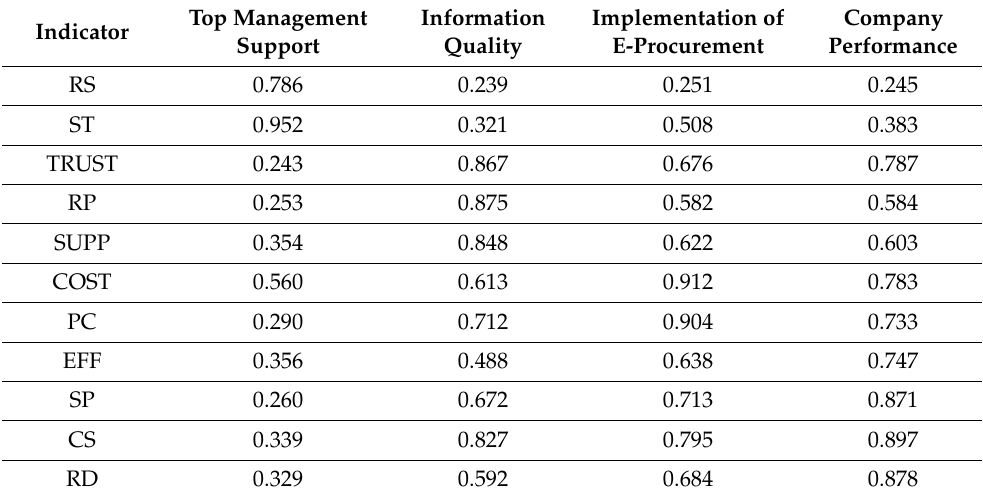
Table 5. Results of cross loading value.